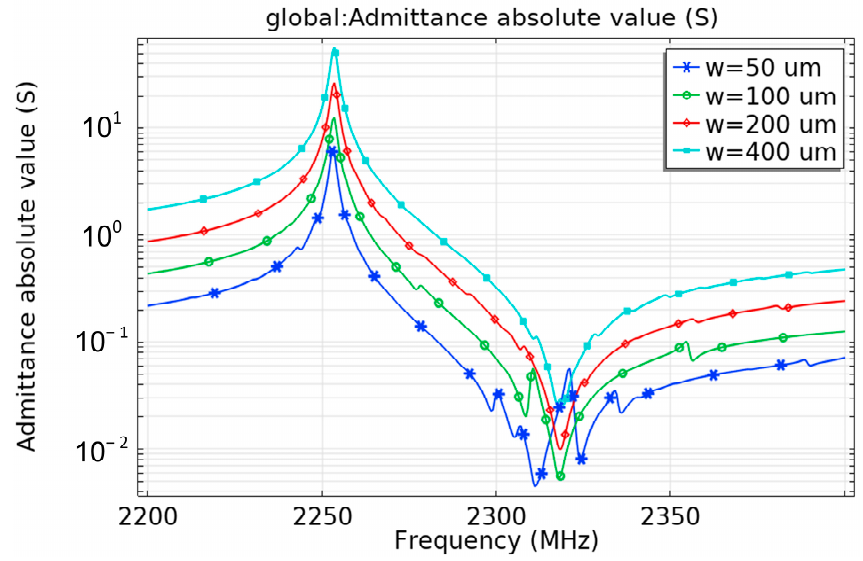
Figure 8. Influence of electrode width on the admittance curve.